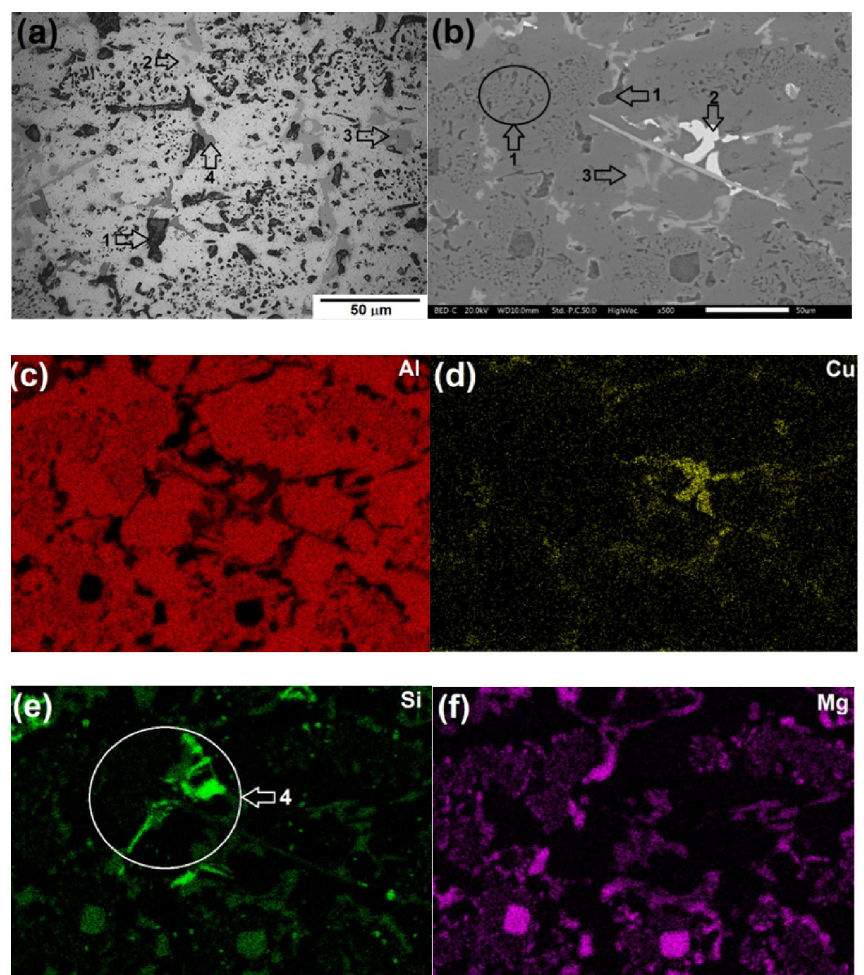
Figure 2. OM (a) and BE-SEM (b) micrographs of the experimental alloys with Cu content of 3%, and EDX-mappings corresponding to Al (c), Cu (d), Si (e) and Mg (f). Arrows indicate second phases: (1) Mg